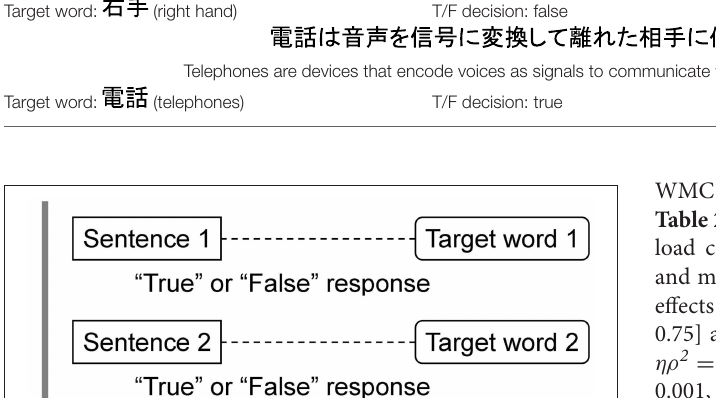
When you make scissors with the right hand and paper with the left hand while playing rock-paper-scissors, the number of folded fingers is two.